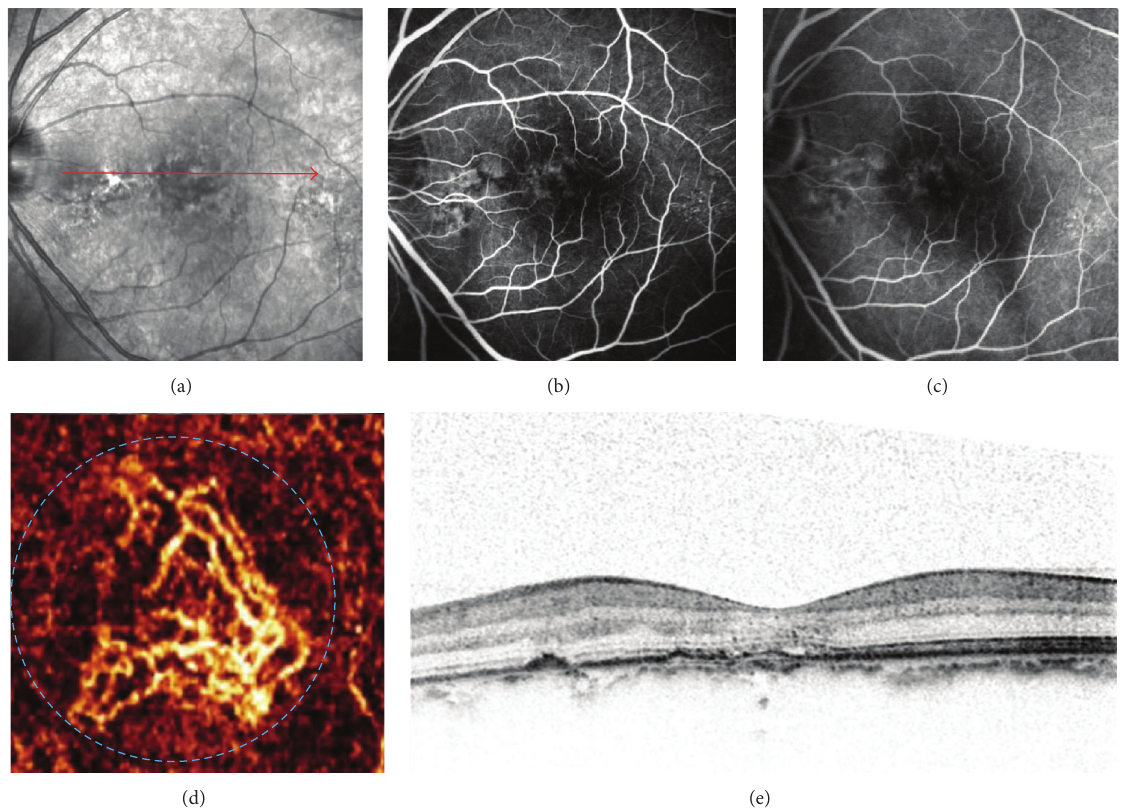
Figure 1: Images of choroidal neovascularization (CNV) observed in false-positive case on optical coherence tomography angiography (OCTA). (a) IR imaging from a 55-year-old man who was previously treated with 3 intravitreal anti-VEGF injections. (b and c) Early- and late-frame FA images of the patient displaying mild hyperfluorescence that is stable throughout the FA in the region of CNV without pooling. (d) A 3∗3 -mm En face angiogram of the outer retina showing a well-circumscribed CNV in the subfoveal (blue dashed circle). (e) Intraretinal cysticspaces and mildRPEirregularityseen onthespectral-domain optical coherence tomography occur at matching locations on IRimaging (red